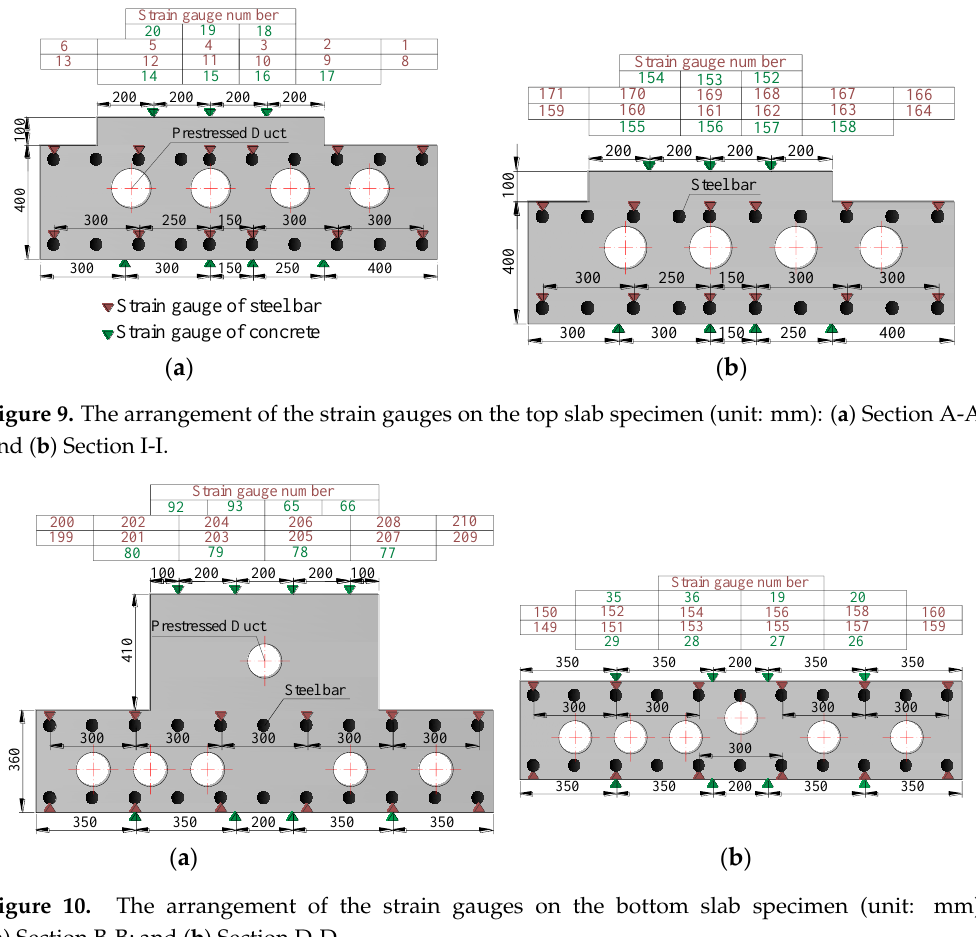
( a ) Section B-B; and ( b ) Section D-D. B-B; and ( b ) Section D-D.